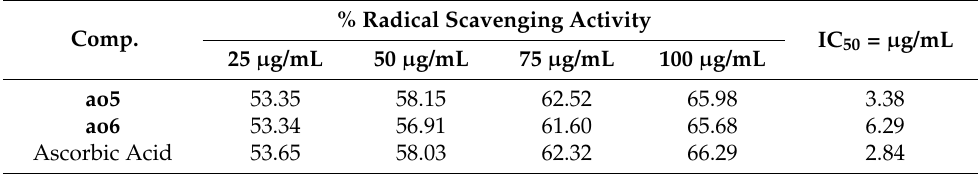
Table 56. In vitro antioxidant activity of the synthesized compounds ( ao5 – ao6 ) using the DPPH scavenging method.